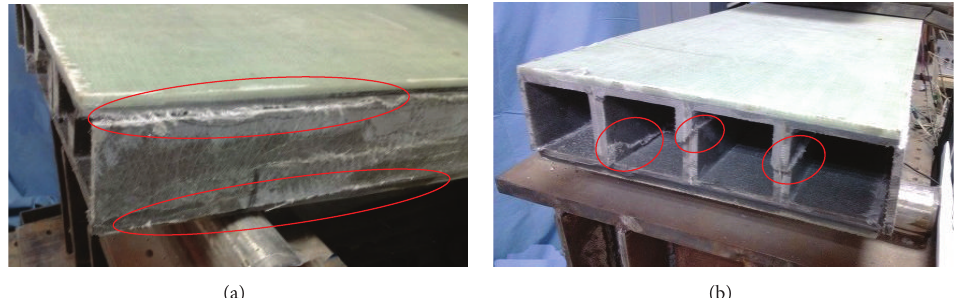
Figure 9: Failure of specimen F( 6 )-GFRP: (a) cracks spreading horizontally and (b) rib fracture.